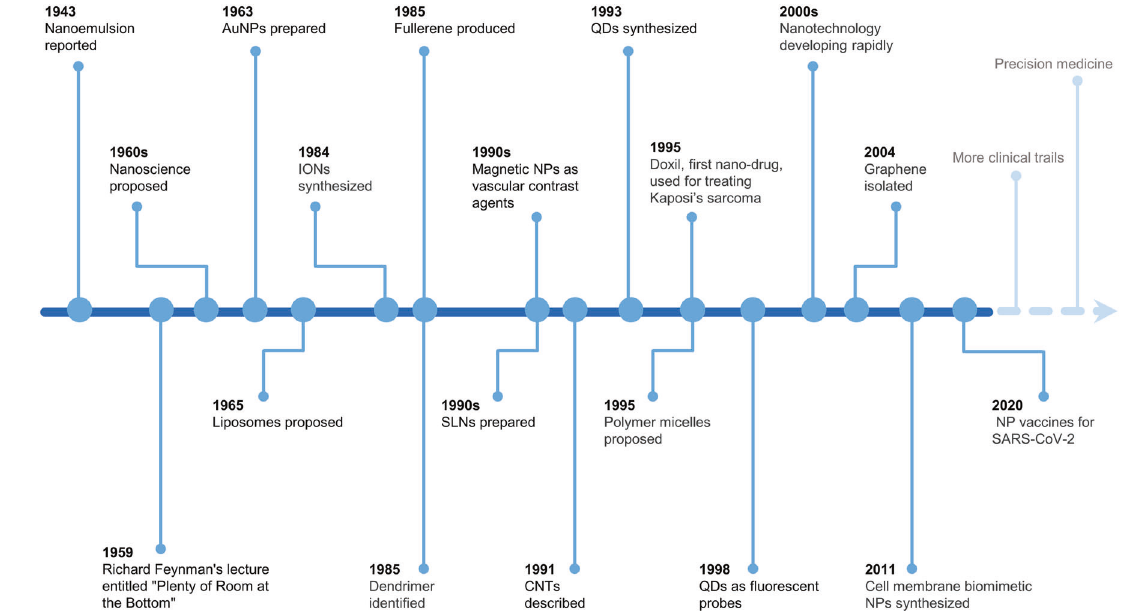
Fig. 1 Timeline of the discovery and research history of nanoparticles. Key discoveries are highlighted. Research on nanoparticles began in the 1960s. Over the last two decades, an increasing number of scientists have devoted themselves to the study of nanoparticles, yielding impressive results in the biomedical fi eld. AuNPs gold nanoparticles, IONs iron oxide nanoparticles, NPs nanoparticles, SLNs solid lipid nanoparticles, CNTs carbon nanotubes, and QDs quantum